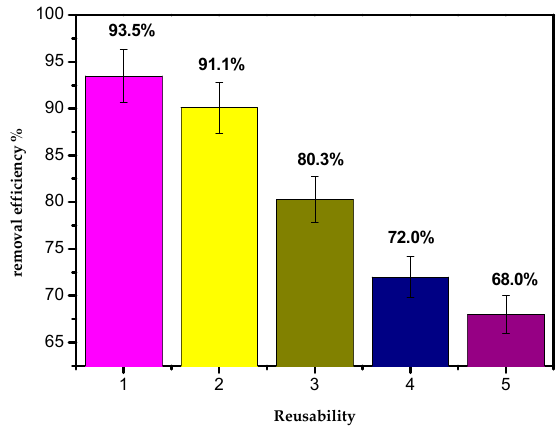
Figure 13. The reusability of AILP.